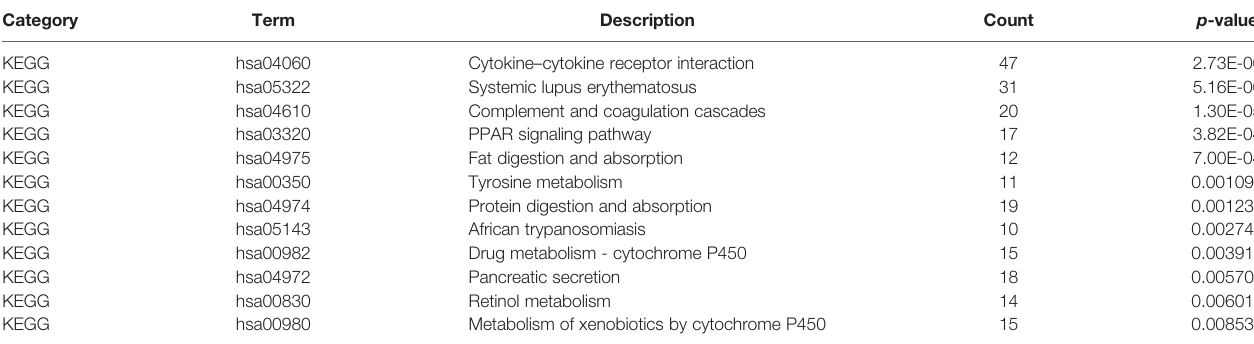
TABLE 2 | KEGG pathway enrichment analysis of 1,855 DEGs associated with ccRCC. Category